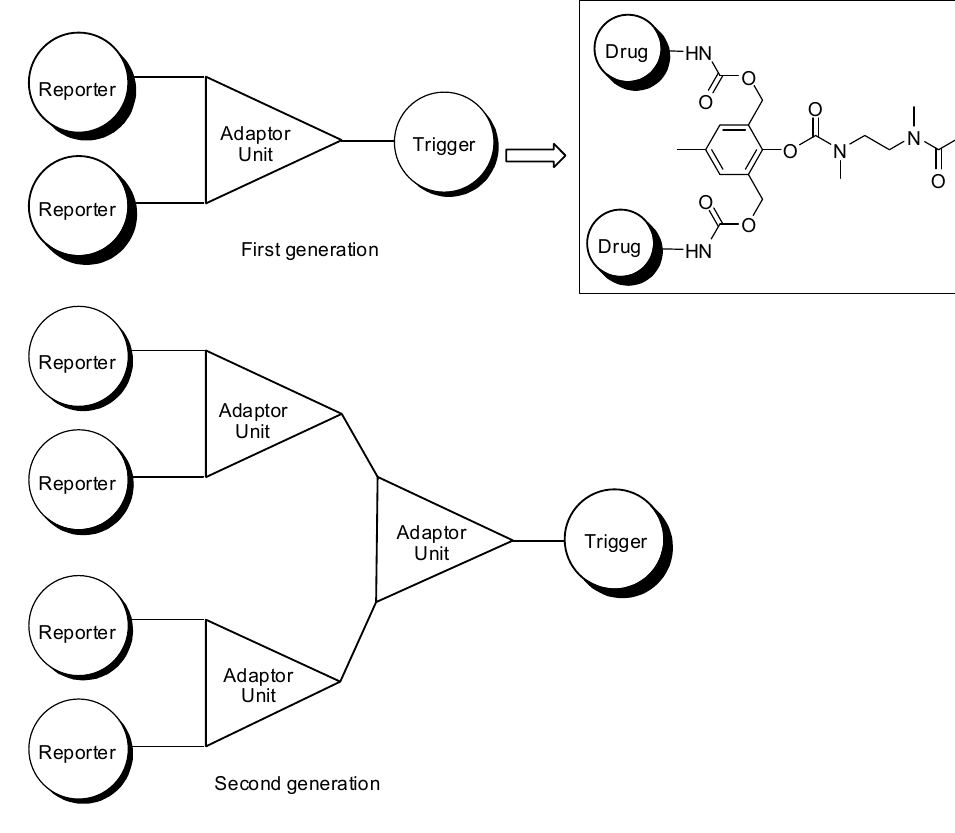
Figure 7. Self-immolative dendrimers [43,44].